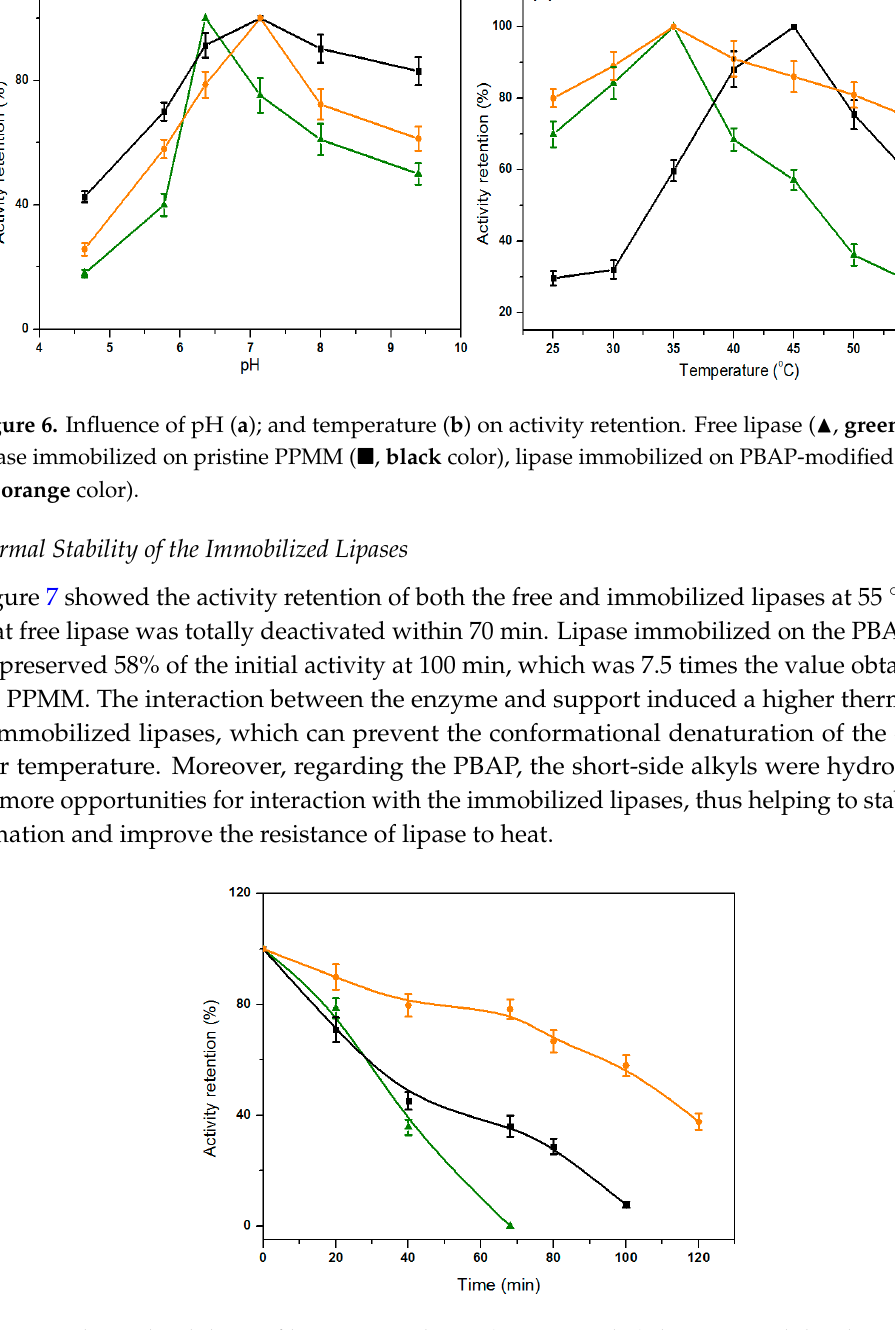
Figure 7. Thermal stabilities of lipases. Free lipase ( ▲ , green color), lipase immobilized on pristine PPMM ( ■ , black color), lipase immobilized on PBAP ‐ modified PPMM ( ● , orange color).